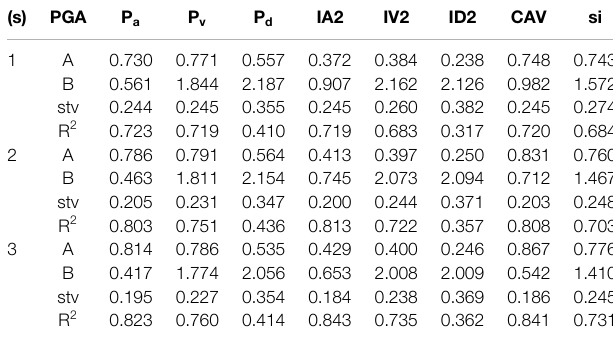
TABLE 2 | Regression coef fi cients of the characteristic parameters and